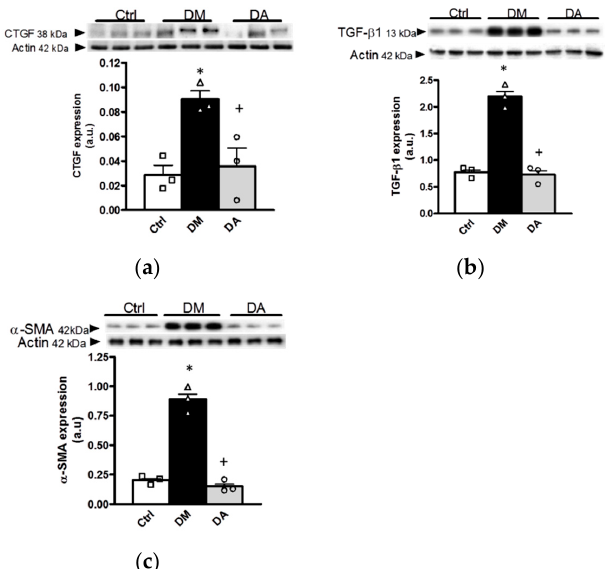
Figure 6. Effects of allicin on fibrotic markers in kidney. ( a ) Connective tissue growth factor (CTGF), ( b ) transforming growth factor- β 1 (TGF- β 1) and ( c ) alpha-smooth muscle actin ( α -SMA). Ctrl: control; DM: diabetes; DA: diabetes treated with allicin; a.u: arbitrary units. For representative Western blotting, 3 randomly selected samples per group were analyzed. Results are presented as mean ± SEM and analyzed by one-way ANOVA. Statistical significance was established as * p < 0.05 vs. Ctrl, + p < 0.05 vs. DM.